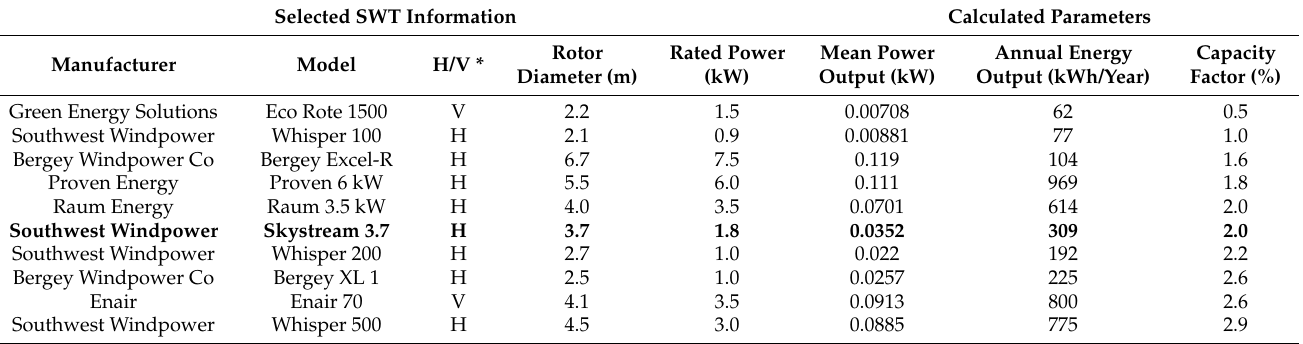
Table 4. Comparison of performance of selected commercially available wind turbines with Skystream ® 3.7 for the USP